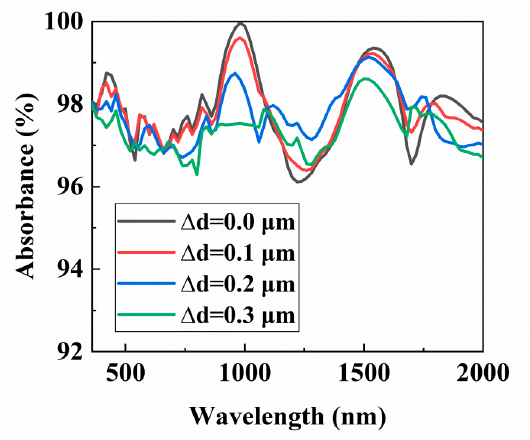
Figure 7. The measured absorbance curves of different diameter deviation values Δ d as a function of of wavelength.